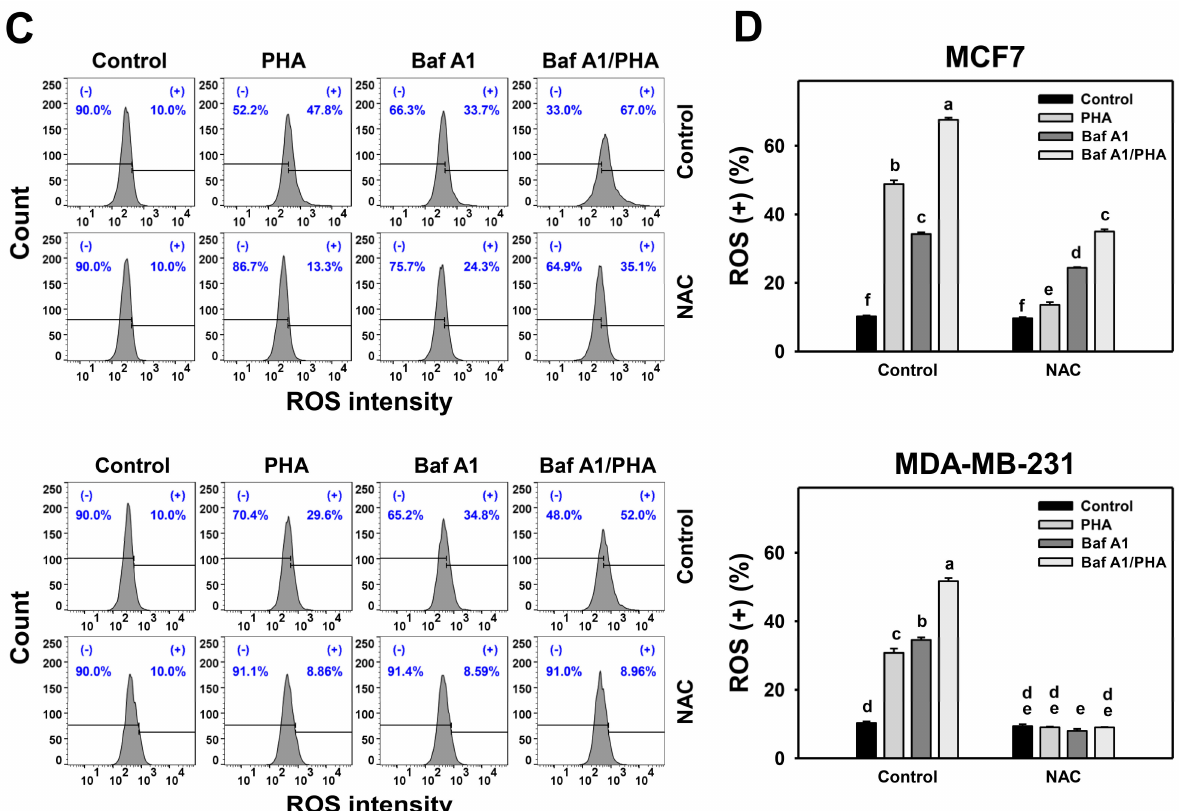
Figure 4. Autophagy downregulation promotes PHA-induced ROS generation in breast cancer cells. ( A , B ) ROS detection. Cells were co-treated with PHA (0 (control), 5, and 10 µ M) and Baf A1 (0 (control) and 100 nM) for 24 h. (+) indicates for ROS (+) (%). ( C , D ) The impact of NAC effect on PHA-induced ROS generation. Cells were pretreated with NAC (10 mM for 1 h) and then co-treated with PHA (control and 5 µ M) and Baf A1 (control and 100 nM) for a 24 h treatment, namely Baf A1/PHA. Data, means ± SDs ( n = 3). Data with non-overlapping lower-case letters differ significantly ( p < 0.05 to